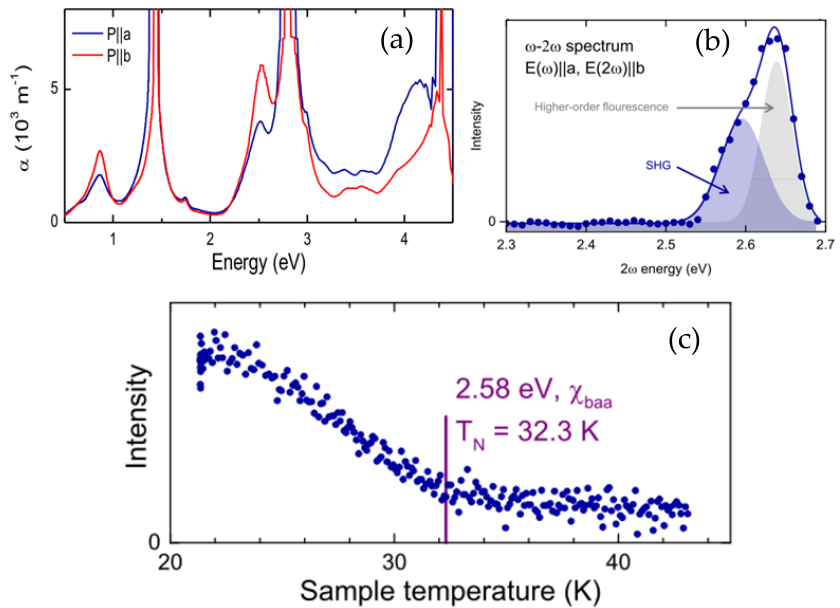
Figure 6. ( a ) The linear spectroscopy with a light incident along c shows strong absorption in the visible and infrared regions. Two strong absorption peaks are observed as 1.4 and 2.7 eV, corresponding to the d 8 orbital of Ni 2+ and d 5 of Mn 2+ ions, respectively, ( b ) the nonlinear excitation spectra with a light incident along c direction, ( c ) the lower-energy SHG signal.